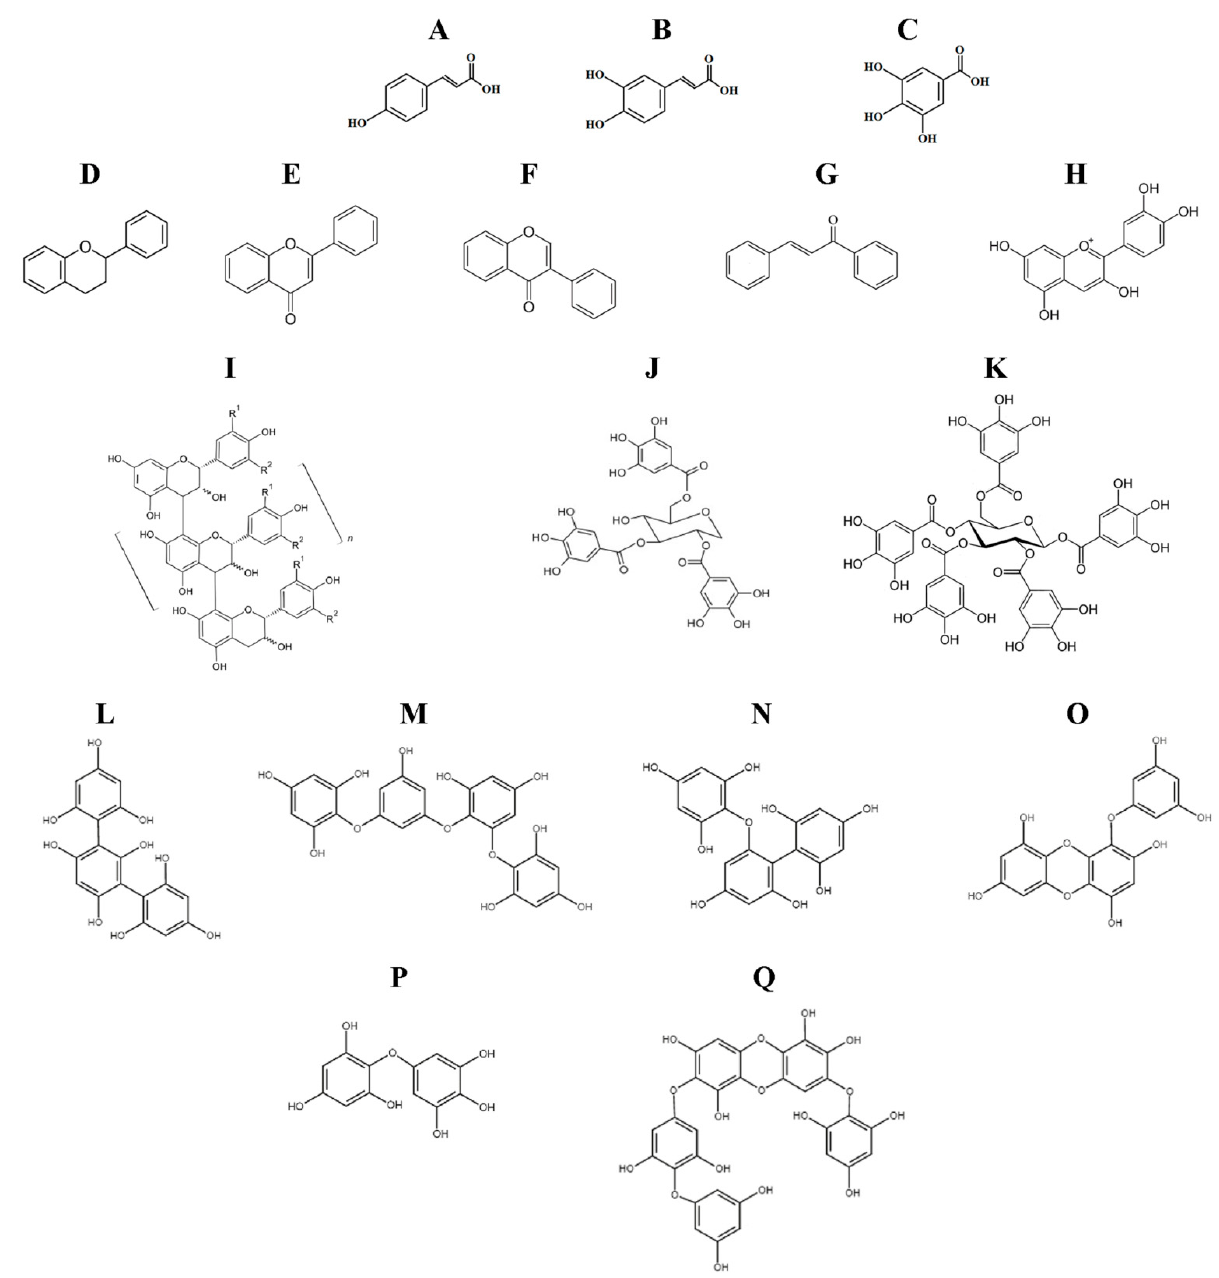
Figure 1. Structures of some phenolic acids and several classes of polyphenols. p -Coumaric acid ( A ), caffeic acid ( B ), gallic acid ( C ), flavan ( D ), flavone ( E ), isoflavone ( F ), chalcone ( G ), anthocyanidin ( H ), condensed tannin ( I ), gallotannin ( J ), ellagitannin ( K ), fucol ( L ), phloroethol ( M ), fucophloroethol ( N ), eckol ( O ), fuhalol ( P ), and carmalol ( Q ).